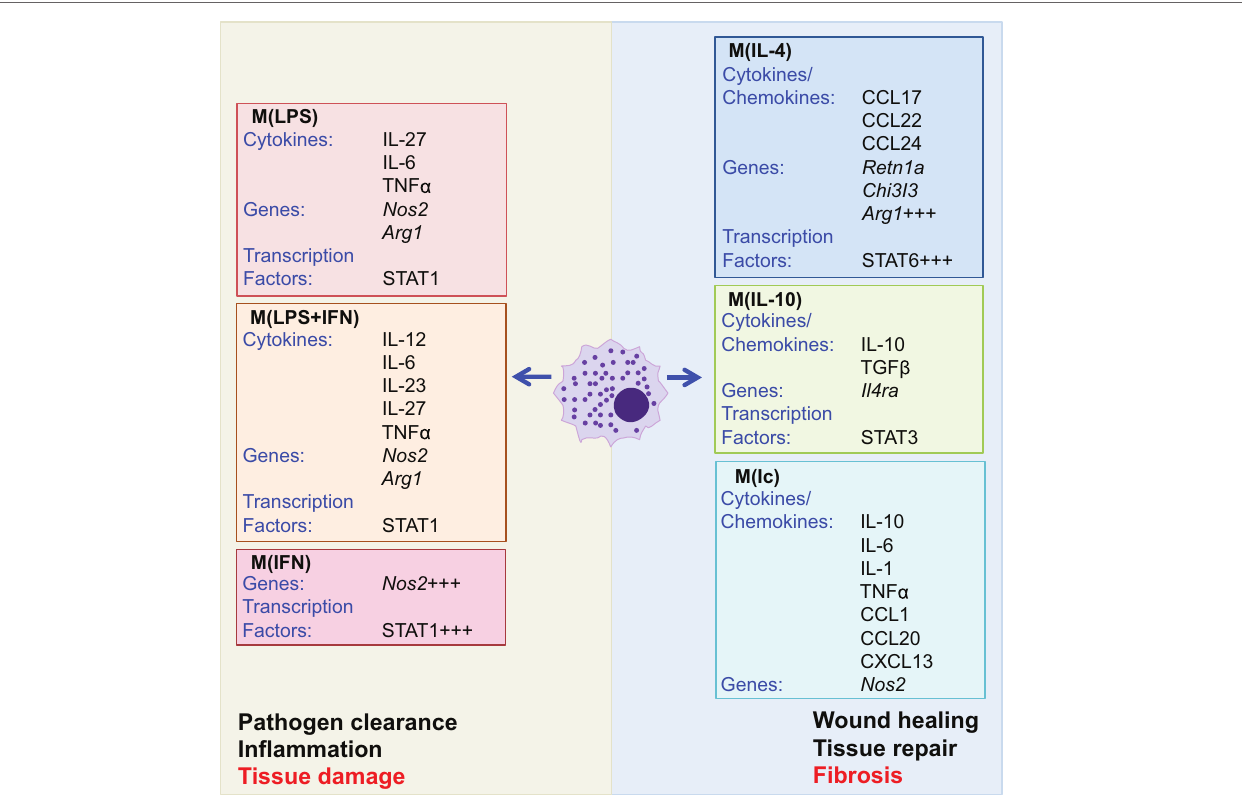
FiGURe 4 | Activated macrophage subtypes . Macrophage subtypes can be described by the experimental stimulus used to activate the cells. Although there are multiple macrophage subtypes, these can broadly be split into two groups associated with inflammation and pathogen clearance or wound healing and tissue repair. Exacerbated activation of both groups has the potential to cause pathological tissue damage or fibrosis (outlined in red text). Macrophages activated with lipopolysaccharide (LPS), interferon (IFN) γ , or a combination of the two (LPS + IFN) are associated with increased expression of Nos2 and production of proinflammatory cytokines. Conversely, activation with IL-4 and IL-10 increases expression of IL-10, TGF β , and arginase (Arg1), while activation with immune complexes (Ic) gives a phenotype similar to that elicited by LPS. However, activation by IL-4, IL-10, and immune complexes is associated with tissue repair and wound healing